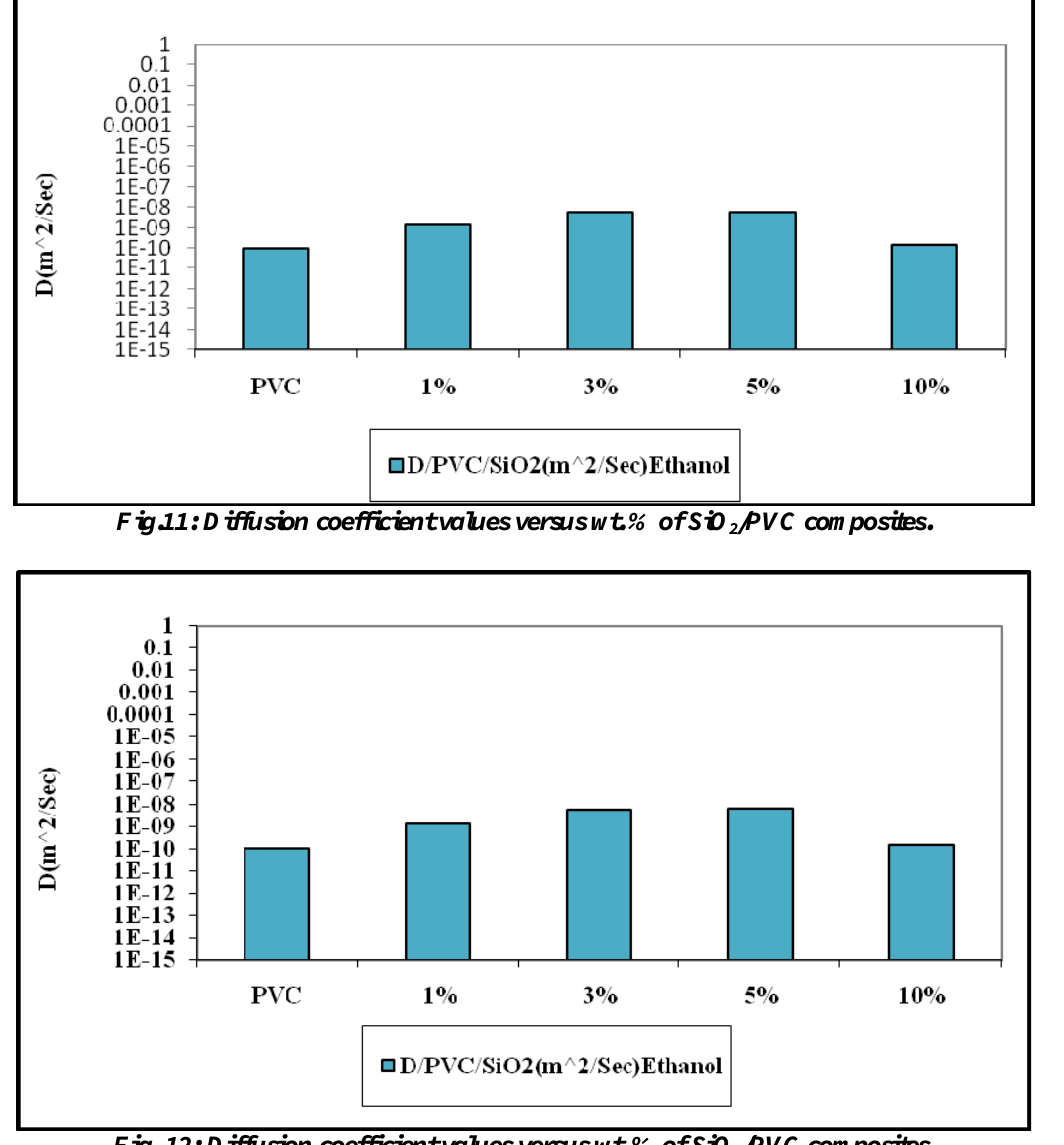
Fig. 12: Diffusion coefficient values versus wt. % of SiO Table 4: Diffusion coefficients values of PVC and SiO